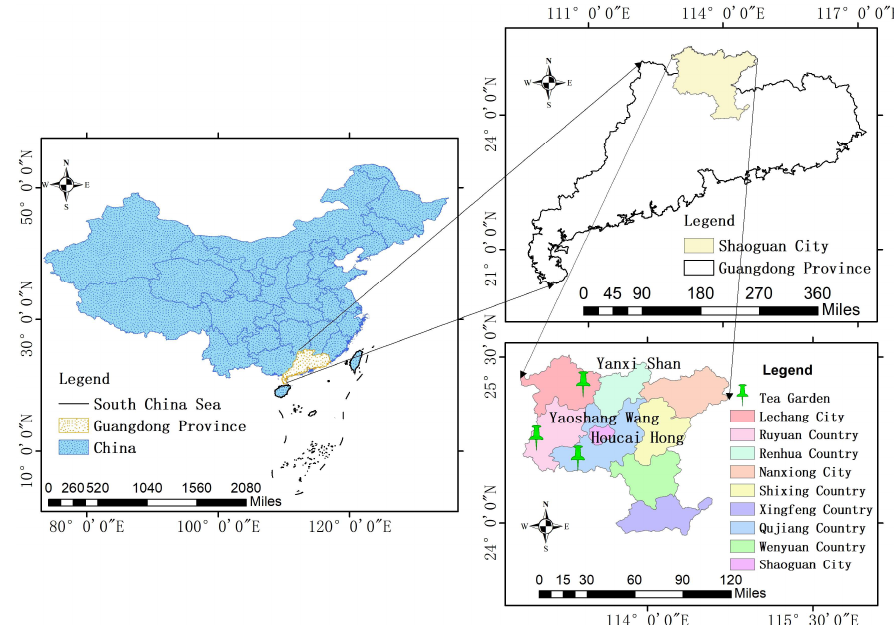
Figure 1. Geographical location of the study area.